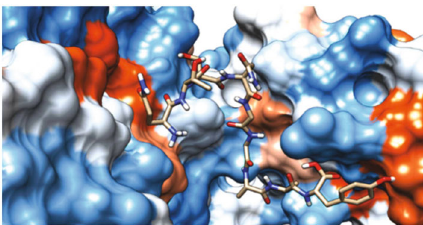
Figure 15: Illustrate the 2D interaction of the best docking poses of QTSNGGAAY in the binding sites of HLA-A ∗